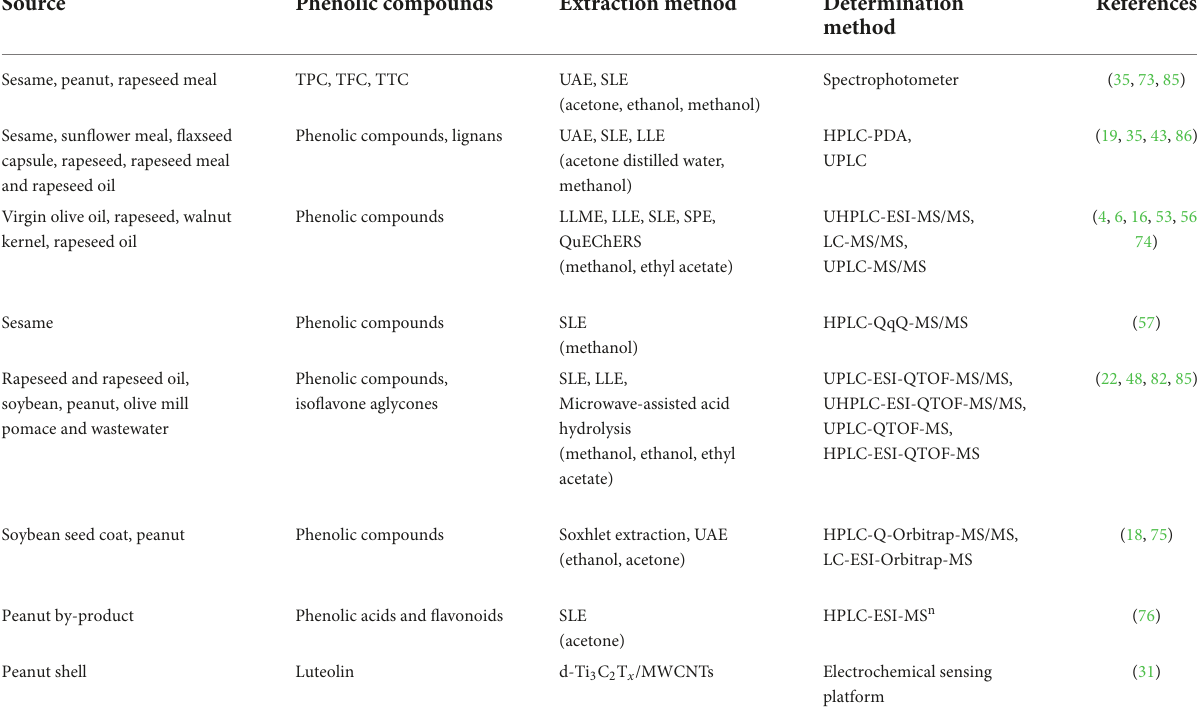
TABLE 2 Extraction and analytical methods of phenolic compounds in oilseeds and their products.